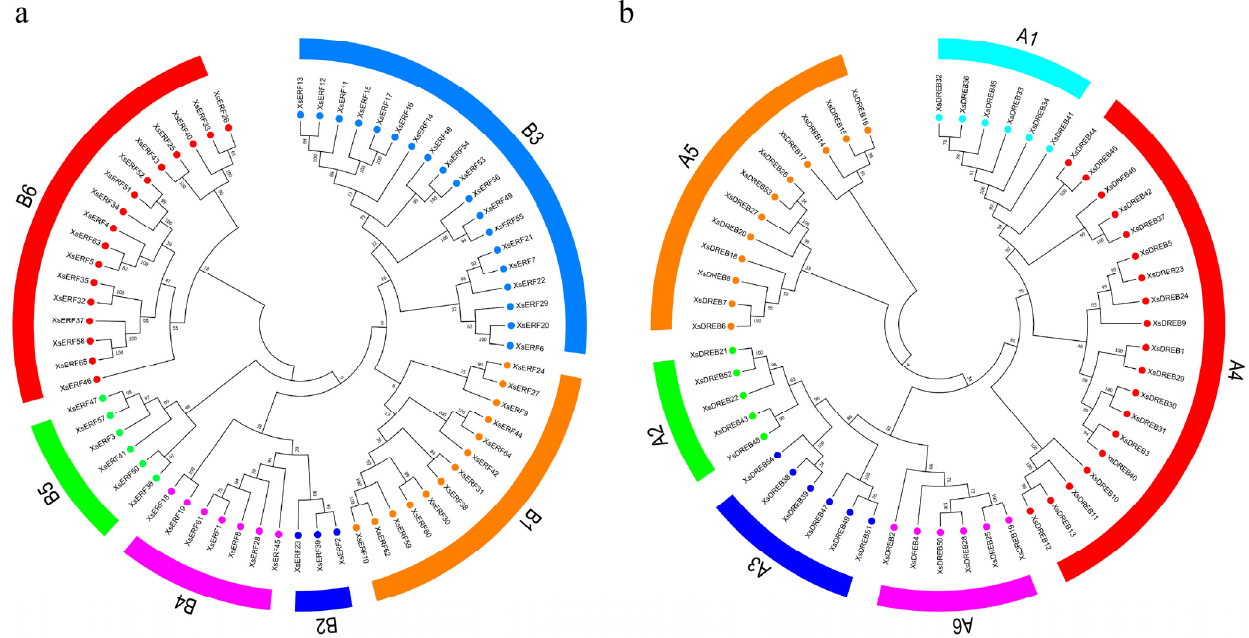
Figure 2. Phylogenetic trees of the ERF and DREB subfamilies of yellow horn. ( a ) Phylogenetic tree of ERF subfamily; ( b ) Phylogenetic trees of subfamilies. The 12 clades of ERF and DREB subfamily genes (B1–6 and A1–6) were grouped depending on their previous classification in Arabidopsis